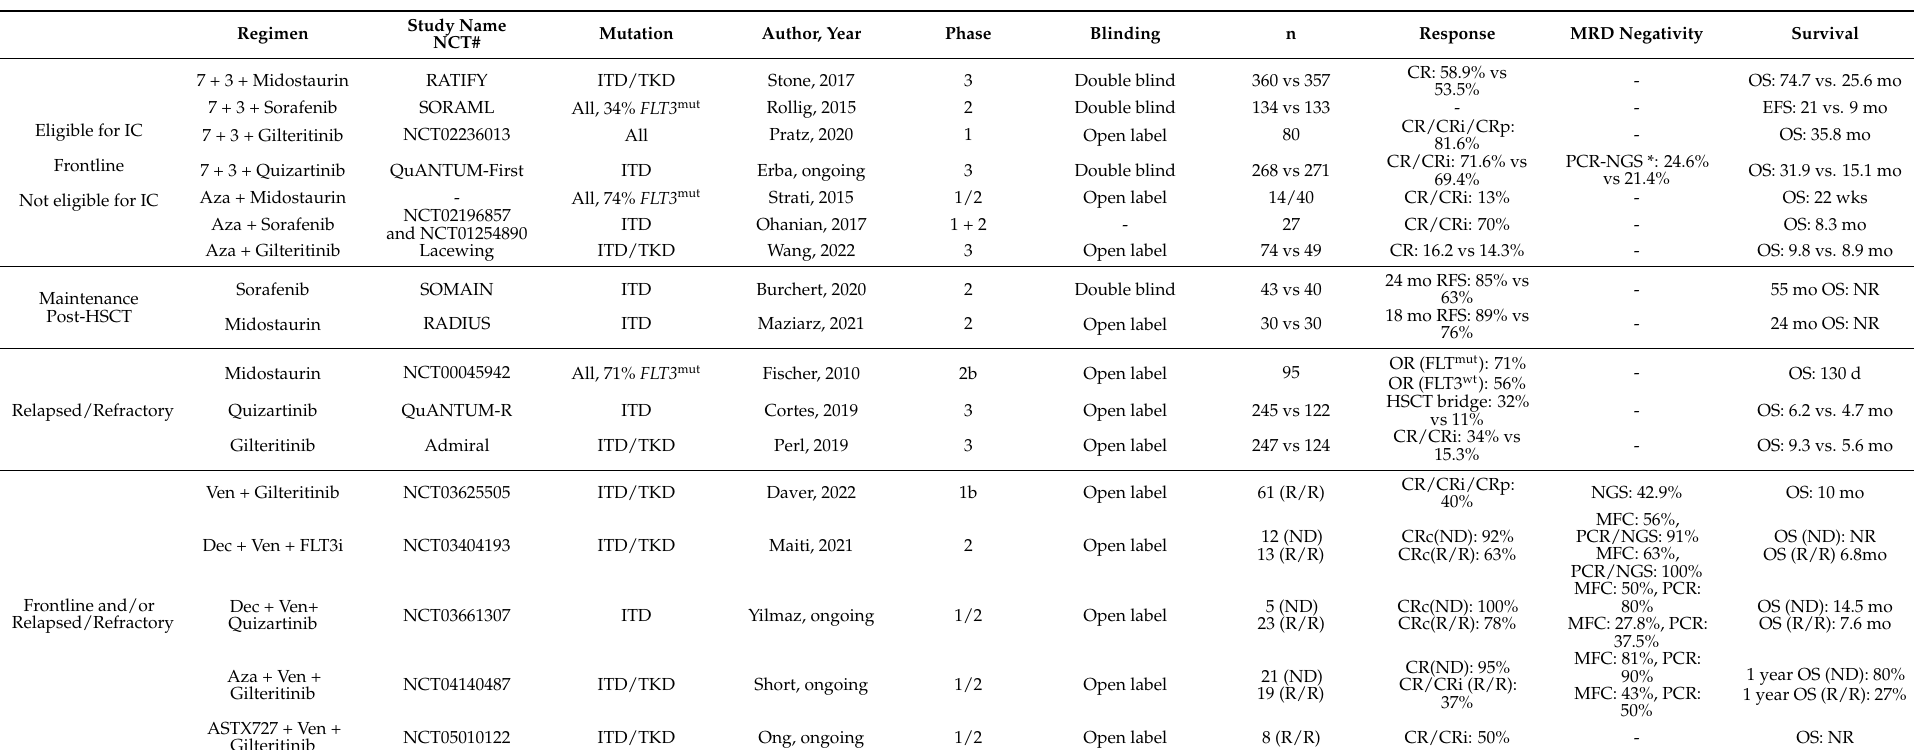
Table 2. Summary of relevant clinical trials using FLT3 inhibitors in